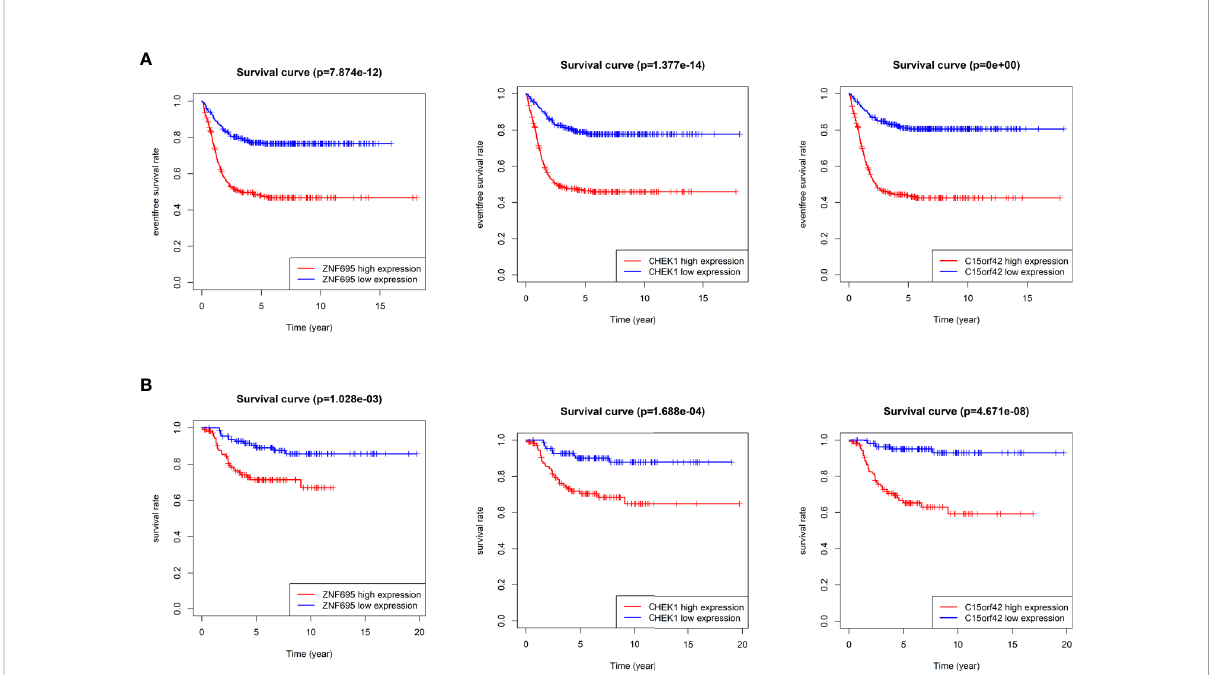
FIGURE 8 Survival analysis of three identi fi ed hub genes (A) Event-free survival analysis of three hub genes in GSE62564 cohort. (B) Overall survival analysis of three hub genes in E-MTAB-8248